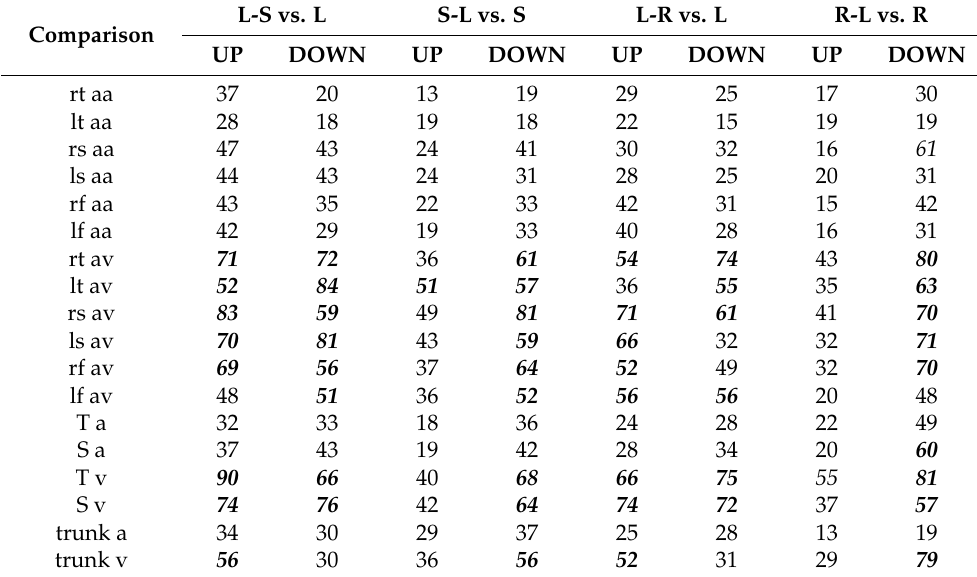
Table 2. Percentage difference of overall parameters (points of significant difference) (%).